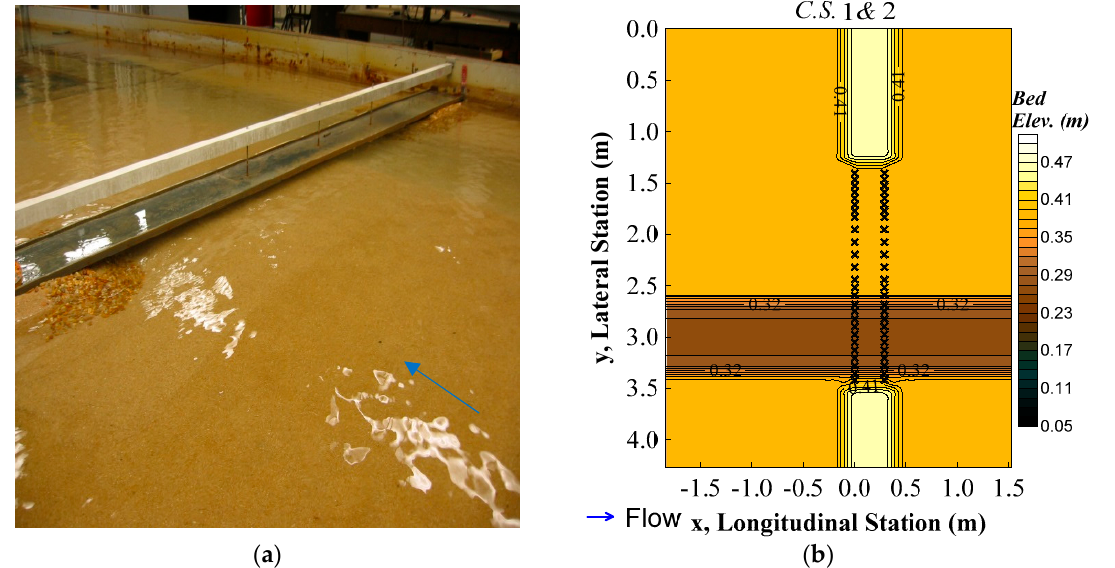
Figure 1. Laboratory model in this study in ( a ) and initial contour with velocity measurements cross sections in ( b ).